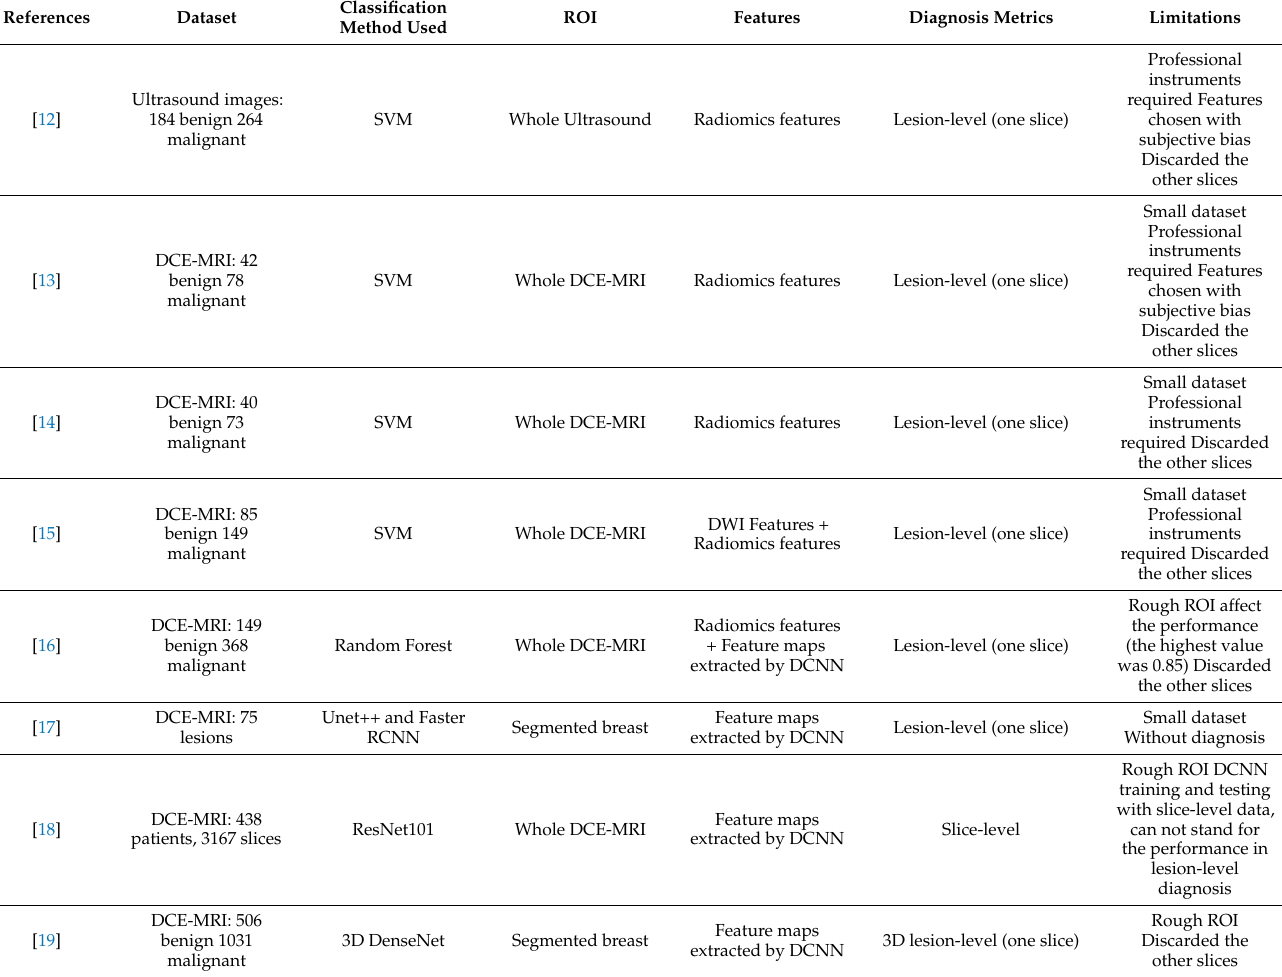
Table 1. Summary of related studies on BC